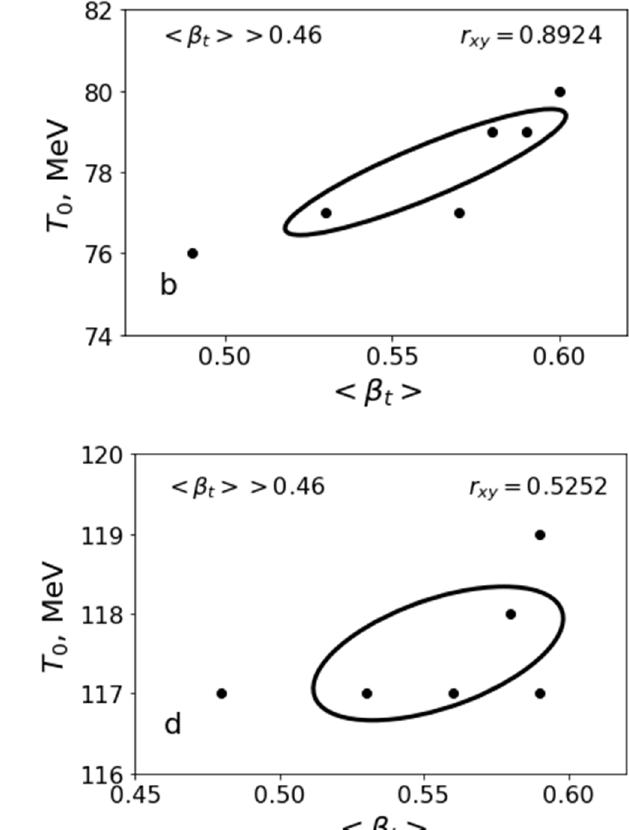
correlation coefficient, r xy , between T 0 and 〈𝛽 (cid:3021) 〉 are also shown in the figures.